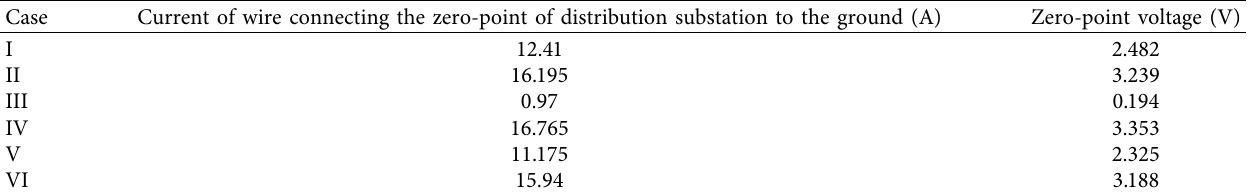
Table 5: Zero-point voltage and current of the wire connecting the zero-point of the distribution substation to the ground. Case